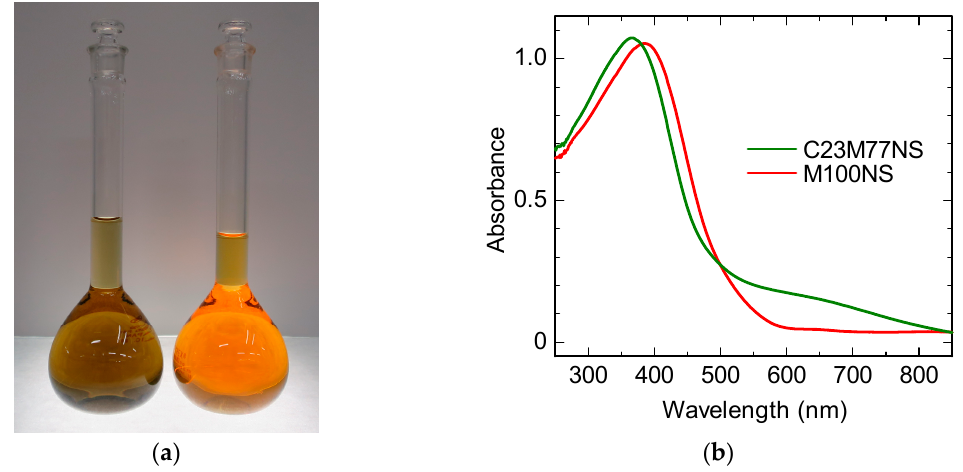
Figure 4. ( a ) Photographs of the colloidal suspensions of C23M77NS (left) and M100NS (right);